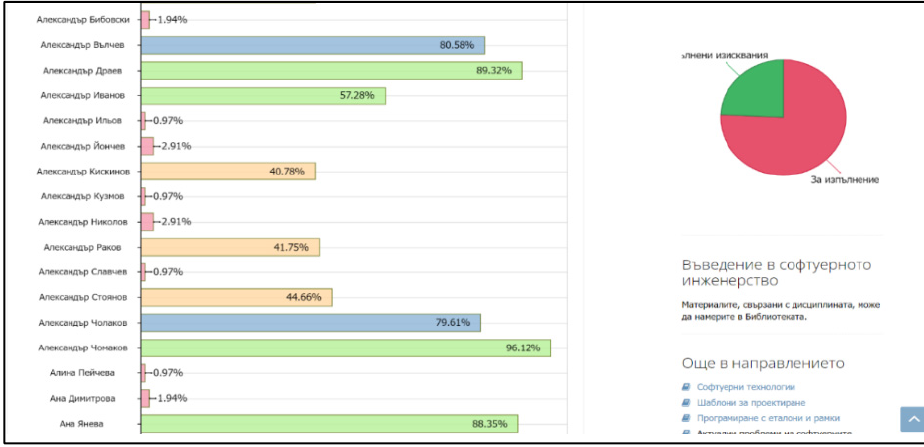
Figure 3. Statistics in the SCORM Player (in Bulgarian).